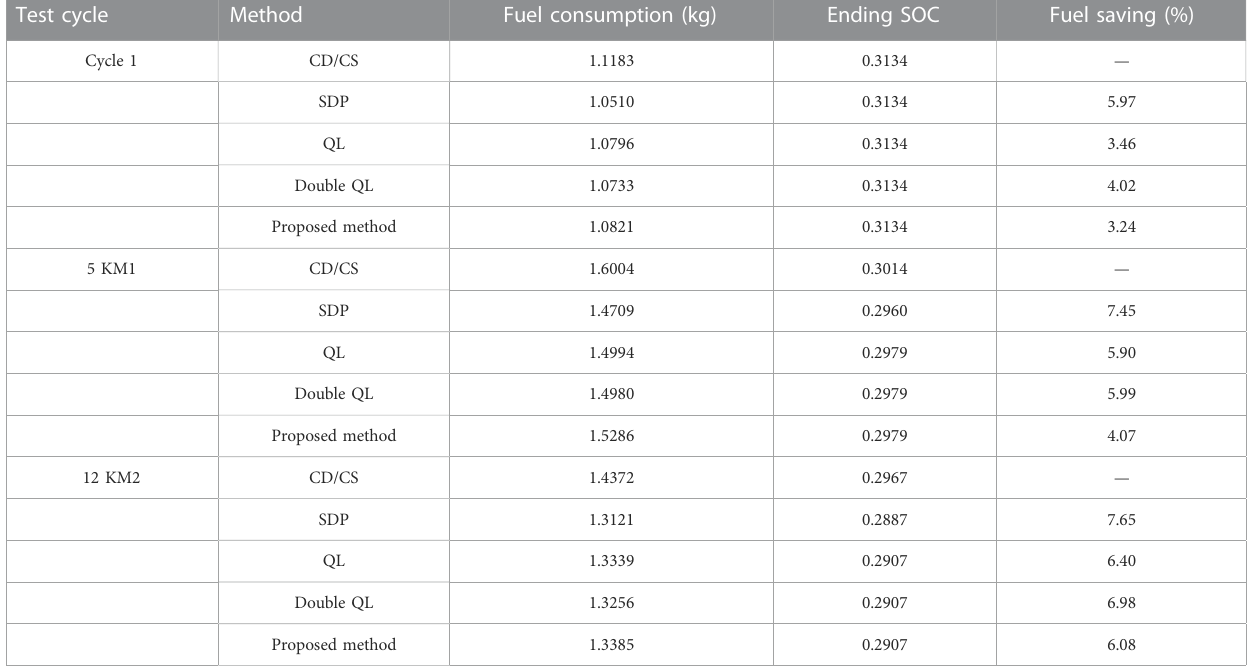
TABLE 5 Comparison of the fuel consumption result of different